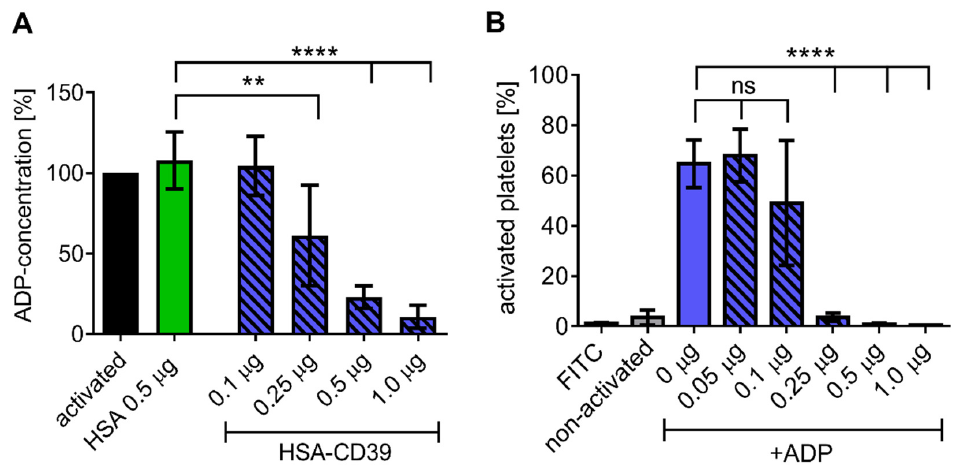
Figure 3. Flow cytometry demonstrating HSA–CD39 functionality when dried in polystyrene tubes and stored at RT for at least 8 weeks. Functionality of HSA–CD39 in hydrolysing ADP is still seen after drying in polystyrene tubes and storage at ( A ) 4 °C for 24 h or ( B ) at RT for 24 h. Flow cytometry was performed to determine the % of activated platelets. ( C ) HSA–CD39 is still functional after 7 days of storage at RT. ( D ) HSA–CD39 is still functional after 8 weeks of storage at RT. The different groups were compared using repeated-measures ANOVA and Bonferroni post hoc tests. ns = non-significant. Values of at least 3 independent experiments are depicted (% activated platelets ± SD, ** p < 0.01, *** p < 0.001, **** p < 0.0001).